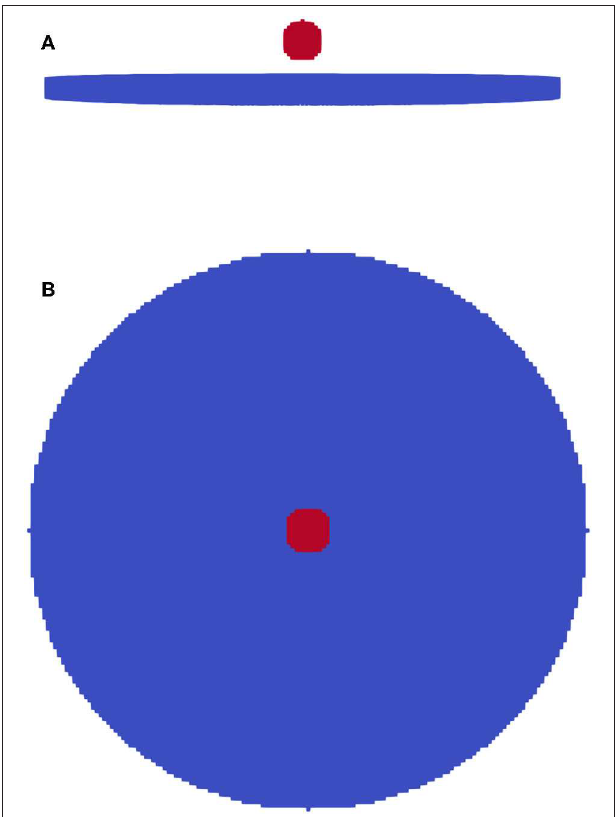
FIGURE 1 | (A) Front and (B) top view of the plate-bullet simulation setup. Note that the glass plate and bullet are colored in blue and red,